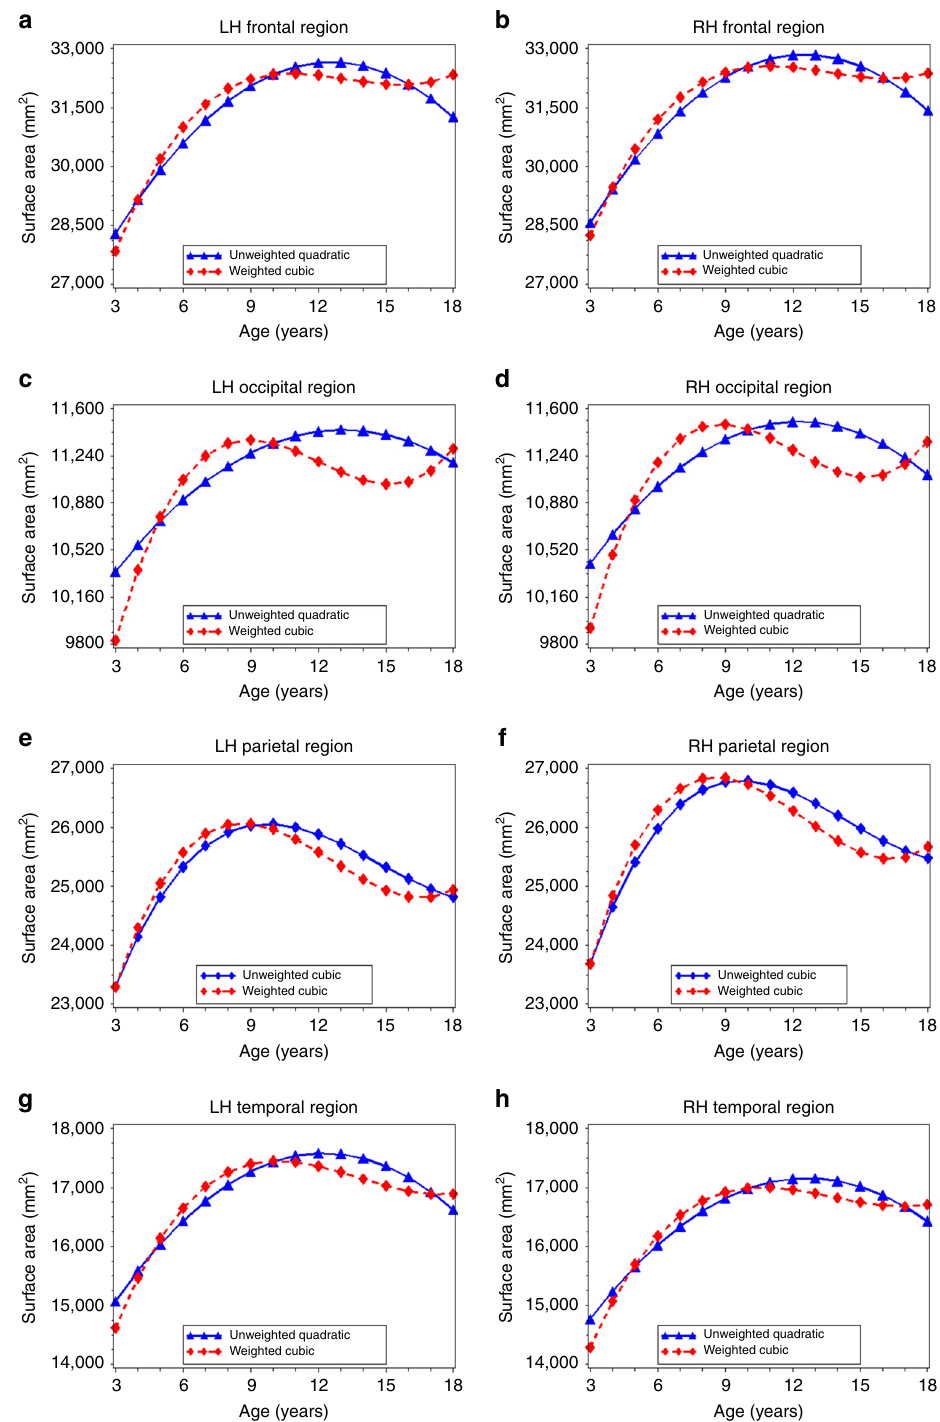
Fig. 4 Age-related variation in cortical surface area for each lobe of the brain. Using the best- fi tting regression models described in Table 2, we calculated the predicted values by age for: left ( a ) and right ( b ) frontal lobe surface area; left ( c ) and right ( d ) occipital lobe surface area; left ( e ) and right ( f ) temporal lobe surface area, and left ( g ) and right ( h ) temporal lobe surface area in the unweighted ( blue lines ) and weighted ( red lines ) samples. LH, left hemisphere, RH, right unweighted study sample. These comparisons revealed differ- ences between the unweighted and weighted sample on important used epidemiologic method of sample weighting to a large, measures of brain development such as age at peak area and volume, and the pattern of age-related change. Differences in age- related variation between the unweighted and weighted sample were observed across all measures of cortical surface area, cortical estimates of age-related variation derived from the original,